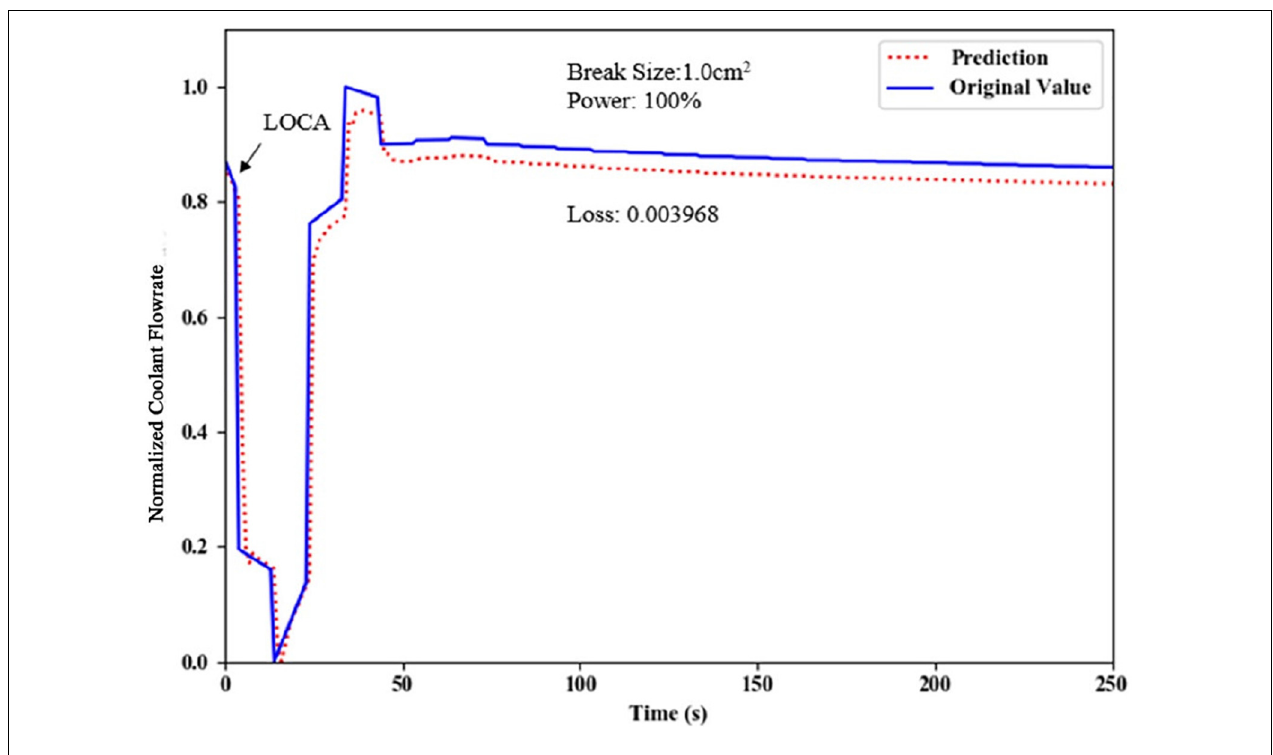
FIGURE 5 | Adaptivity verification of the prediction model.